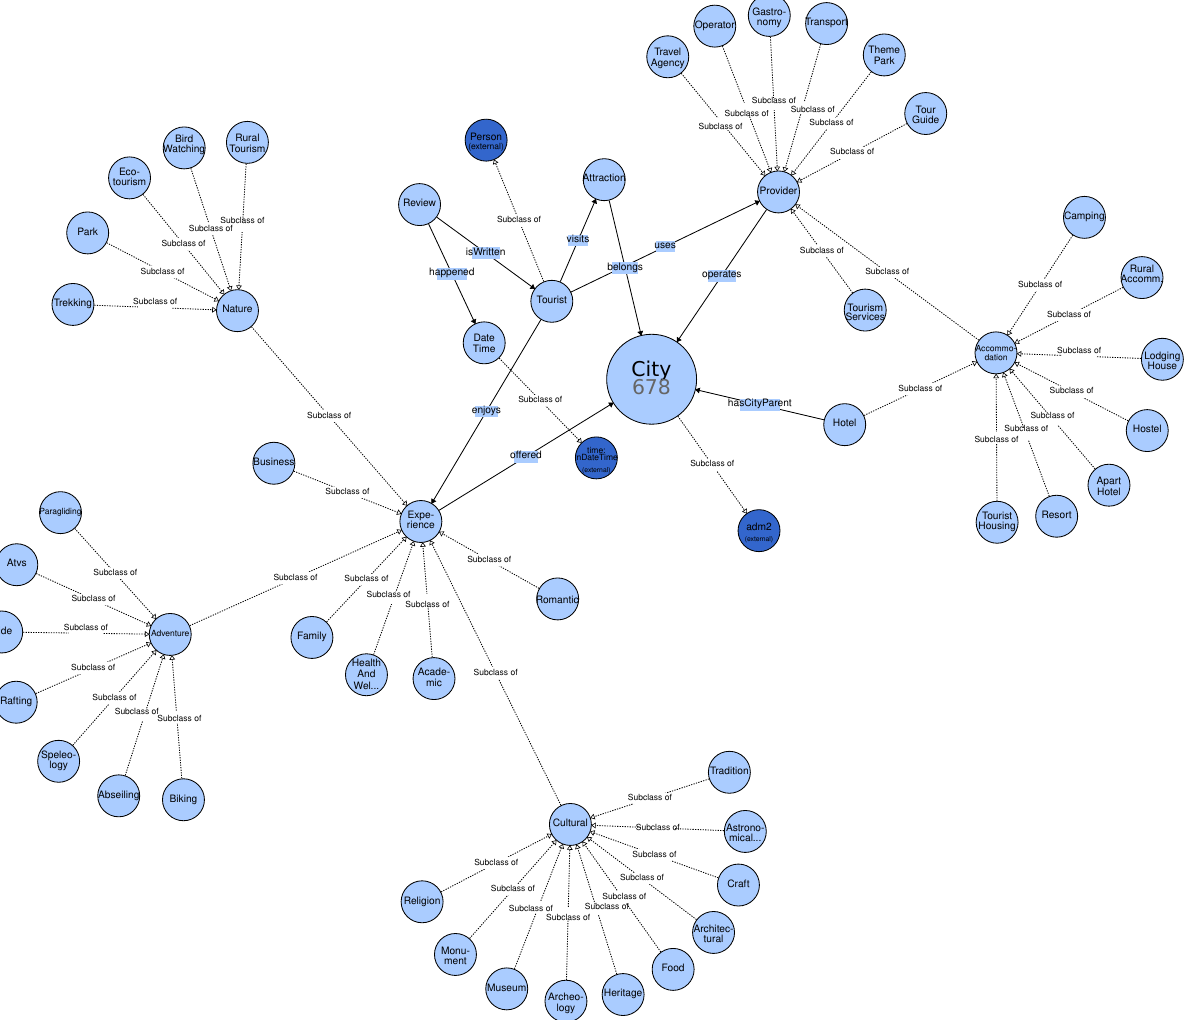
Figure 2. Snippet of the image of the upper levels of OntoTouTra (using WebVOWL